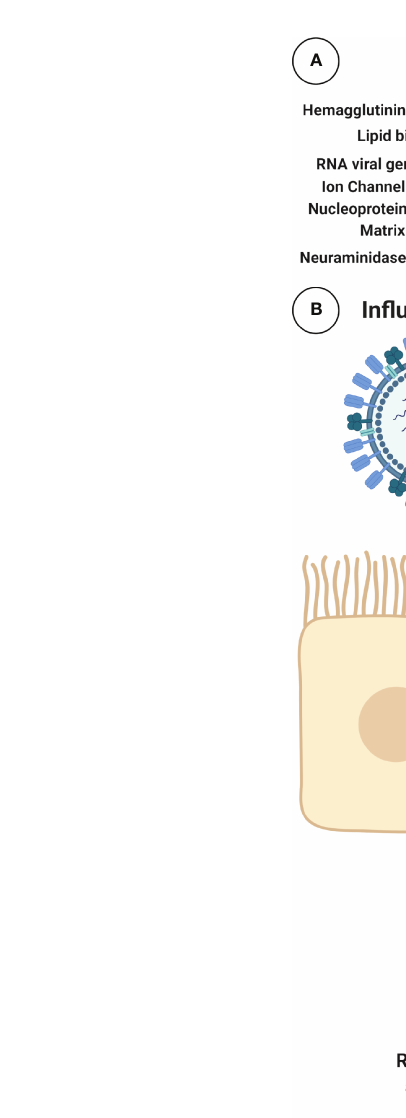
FIGURE 2 | Schematic Diagram of IAV Structure and Reassortment. (A) Figure shows a schematic cross-section of the in fl uenza virus virion with main components labeled. Surface glycoproteins, trimeric hemagglutinin (HA) and tetrameric neuraminidase (NA), play important role in viral entry and egress and are major targets for immune responses following infection or immunization. In particular, the highly conserved stalk domain of HA is a target for universal in fl uenza virus vaccines. Note: HA stalk and NA stalk are not shown as trimeric or tetrameric structures. Internal, highly conserved antigens matrix protein-1 (M1) and nucleoprotein (NP) are targets for cytotoxic T lymphocytes (CTLs). Note: icons for NP, which coats the viral RNA, and the viral ribonucleoproteins (vRNPs) which contain viral RNA, NP and polymerase are not shown. (B) In fl uenza A viruses (IAVs) can evolve to generate viruses with pandemic potential by antigenic shift, using a process of genome reassortment. Co-infection of susceptible cells with more than one distinct IAV can result in the selection of progeny with shuf fl ed gene segments and potentially a new HA or NA, against which humans have no prior immunity. Figure created with © BioRender -